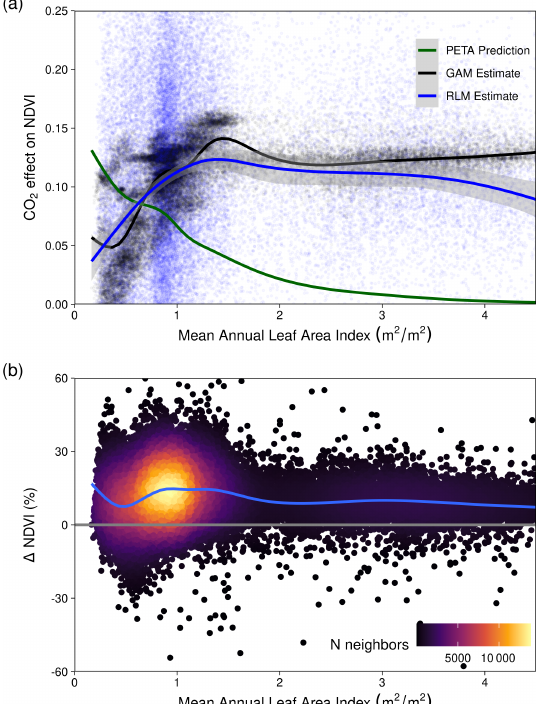
Figure A9. (a) The fractional increase in NDVI from CO 2 is plotted following predictions from the partitioning of equilibrium transpiration and assimilation (PETA) hypothesis (green), the Generalized Additive Model (GAM; see “Methods”, Eq. 6) estimates, and the pixel-level Robust Linear Model (RLM; see “Methods”, Eq. 5) estimates. Note that we substitute NDVI for the leaf area formulation of the PETA hypothesis (Donohue et al., 2017) because we assume a linear relationship between relative NDVI increase and relative leaf area increase (Donohue et al., 2013; Carlson and Ripley, 1997). (b) The relative change in NDVI between 1982–2019 across the range of mean annual leaf area index calculated with MCD15A3H from 2002–2019.